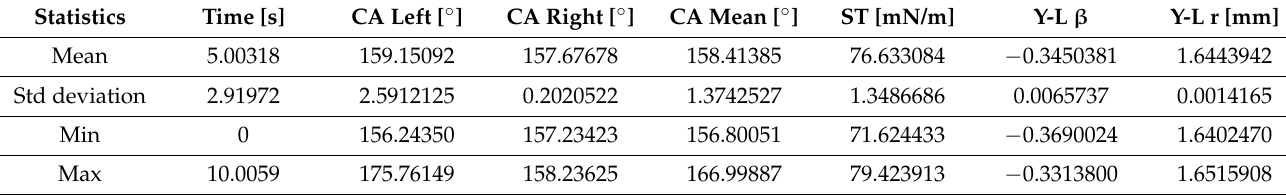
Table 3. The results of wettability properties of SiO 2 NPs.